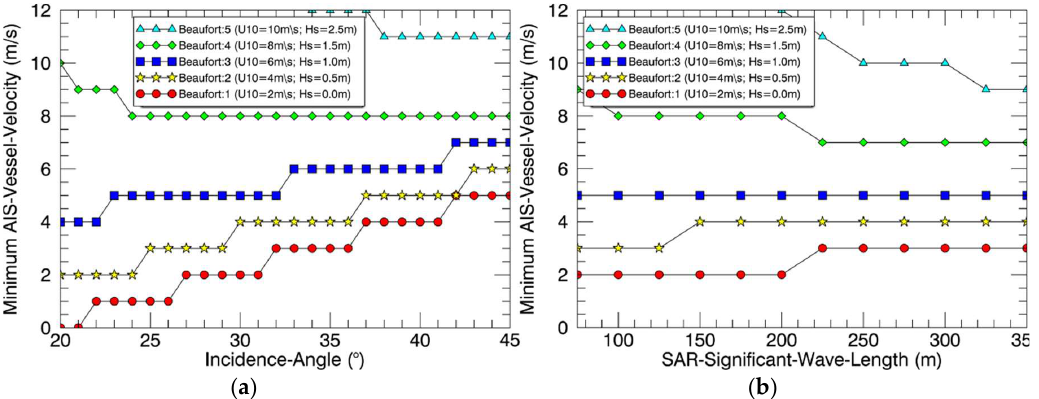
Figure 11. Minimum vessel velocity calculated for the default parameters and changing Incidence-Angle (a) and SAR-Significant-Wave-Length (b)respectively. Results obtained by varying SAR-Wind-Speed and SAR-Significant-Wave-Height are displayed by different line markers. The minimum probability of detection was set to 80%.